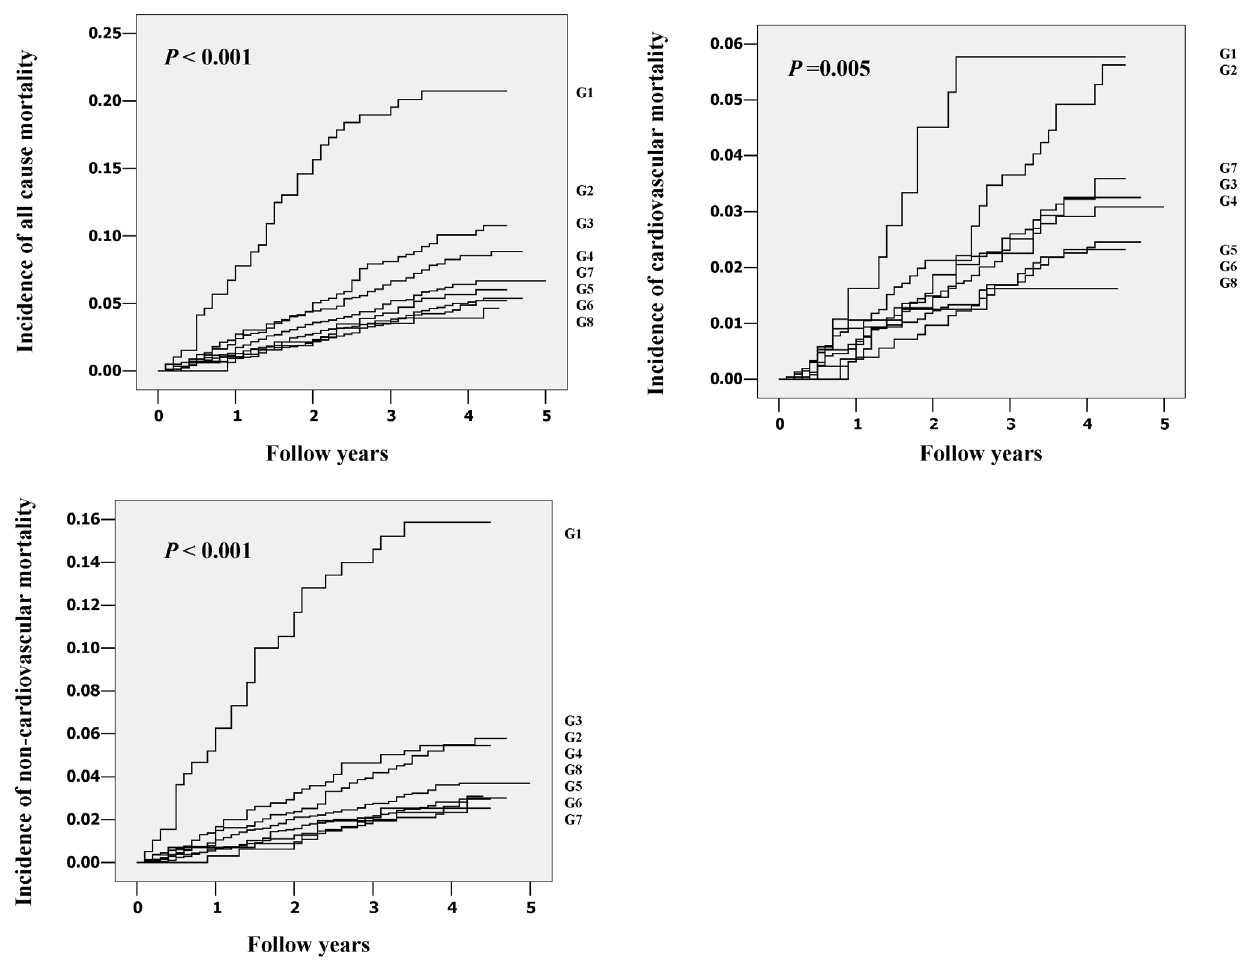
Figure 1. Cumulative incidence of all causes mortality, cardiovascular mortality and non-cardiovascular mortality across eight groups of body mass index (BMI). G1 to G8 indicate ascending BMI groups. Cutoff points were 18, 20, 22, 24, 26, 28,30 kg/m 2